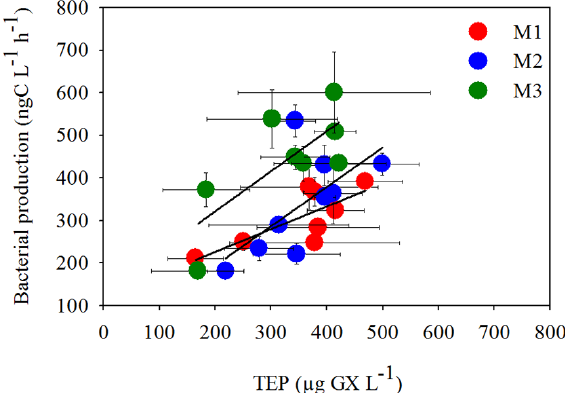
Figure 5. Relationship between heterotrophic bacterial production (BP) (ngCL − 1 h − 1 ) and TEP concentrations (µgGXL − 1 ) during phase 2 (days 15–23) when BP increased following the enhanced PP (Van Wambeke et al., 2016), for Mesocosm 1 (M1, red dots), Mesocosm 2 (M2, blue dots), Mesocosm 3 (M3, green dots). Pear- son’s linear regressions yielded R 2 = 0 . 57 for M1, 0.42 for M2, and 0.56 for M3 respectively. Significant correlations were observed for all mesocosms and are detailed in Table S2. Error bars represent ± 1 standard